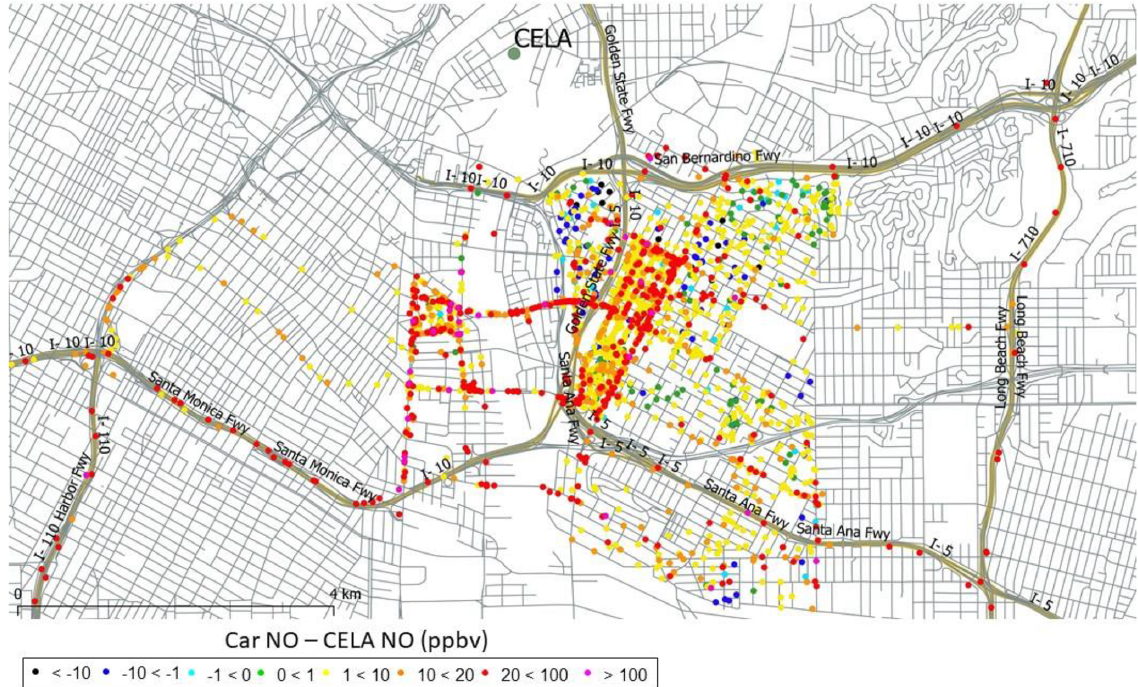
Figure 1. Paired differences in 1min NO concentrations measured by cars and by the air quality monitor in downtown Los Angeles (CELA) during 3–12 August 2016. Map generated with QGIS version 3.2.2 (https://qgis.org/en/site/, last access: 12 June 2020) open-source